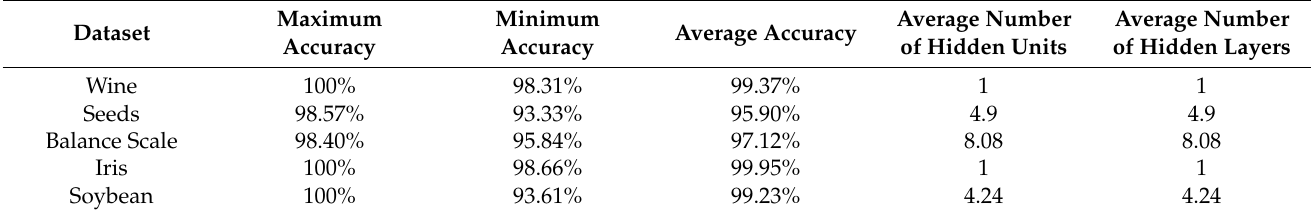
Table 4. The simulation results of the CCNN-jDE-B